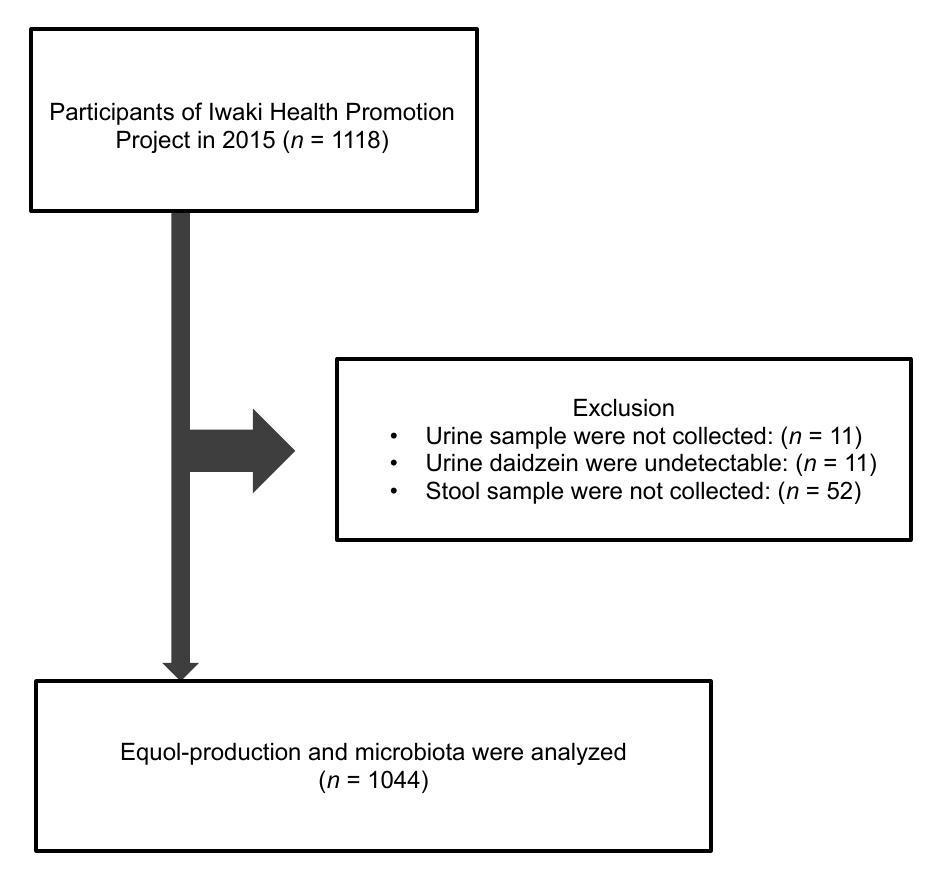
Figure 1. Study flow of subjects. A total 1044 subjects were enrolled from 1118 adults who participated in Iwaki Health Promotion Projects in 2015.